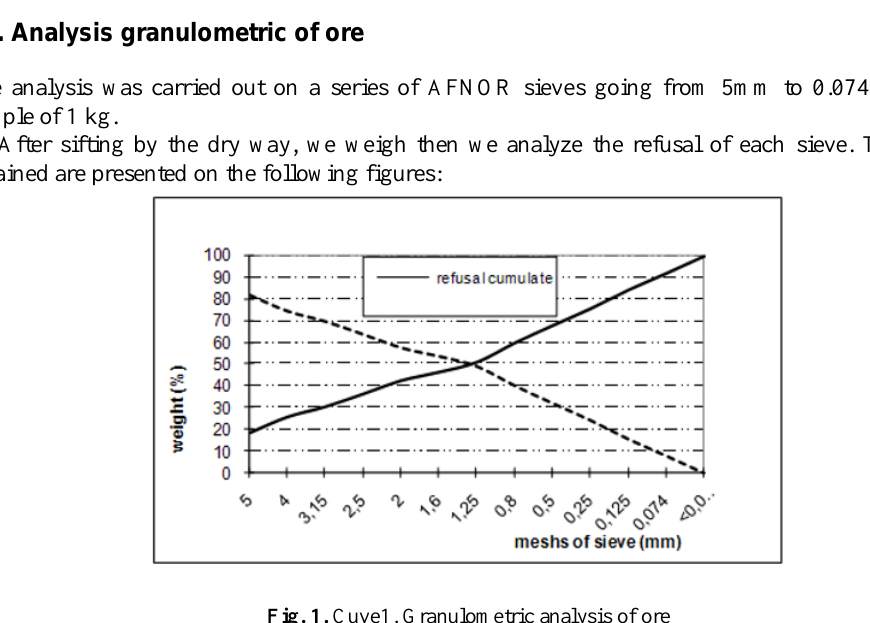
Fig. 1. Cuve1. Granulometric analysis of ore